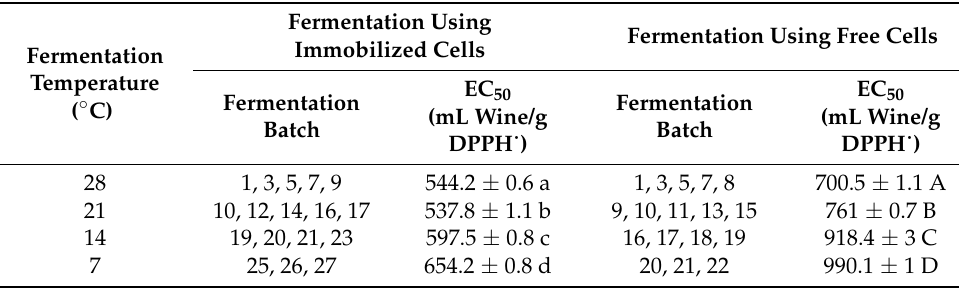
Table 8. Antioxidant activity of wines produced from must (12.5 ◦ Be) using immobilized and free cells at 28, 21, 14 and 7 ◦